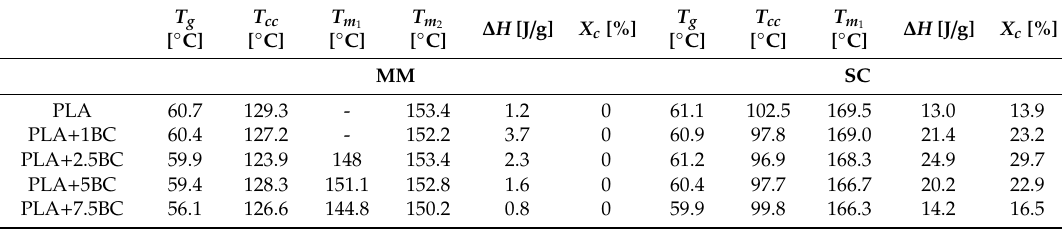
Figure 5. Differential scanning calorimetry (DSC) thermograms recorded during the second heating scan for neat PLA and BC-containing composites obtained through melt mixing ( A ) and solvent casting ( B ). Table 1. Main thermal properties collected during the second heating scan for all investigated systems. PLA, poly(lactic acid); BC, biochar; MM, melt mixing; SC, solvent casting.